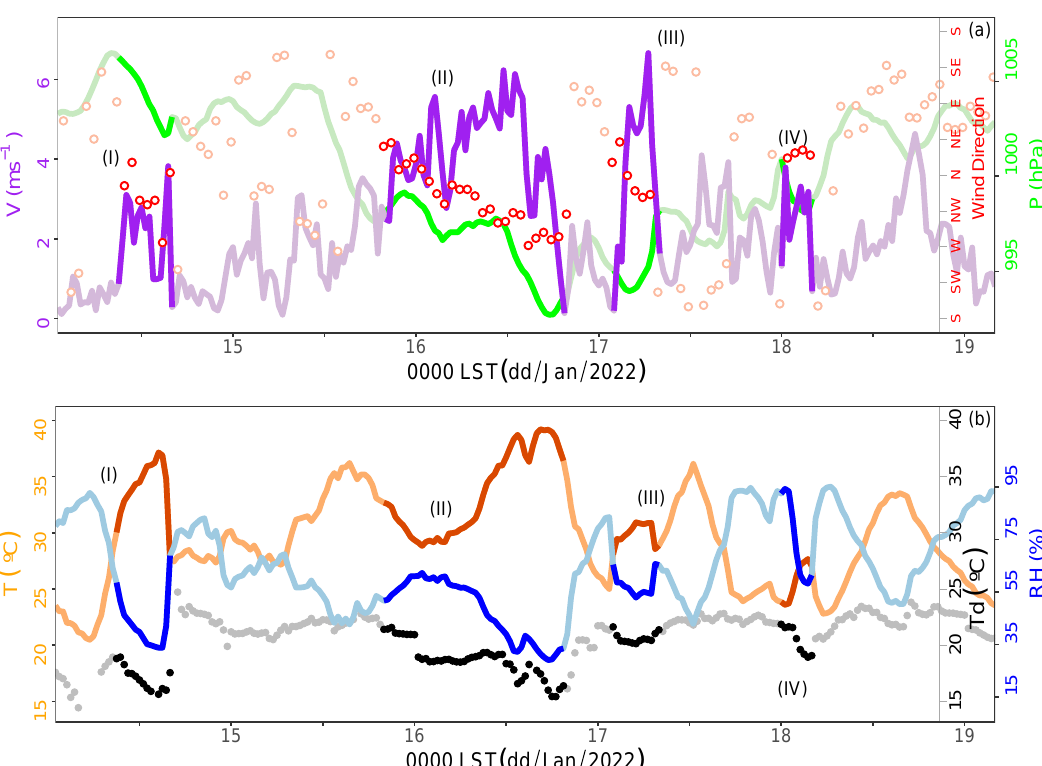
Figure 6. Time series of ( a ) wind speed ( V ; purple line), wind direction (red dots), and air pressure ( P ; green line); ( b ) air temperature ( T ; orange line), relative humidity ( RH ; blue line), and dew point ( Td ; black line) recorded during 14–19 January 2022. The highlighted periods, indicated by dark colors, represent episodes of DWs